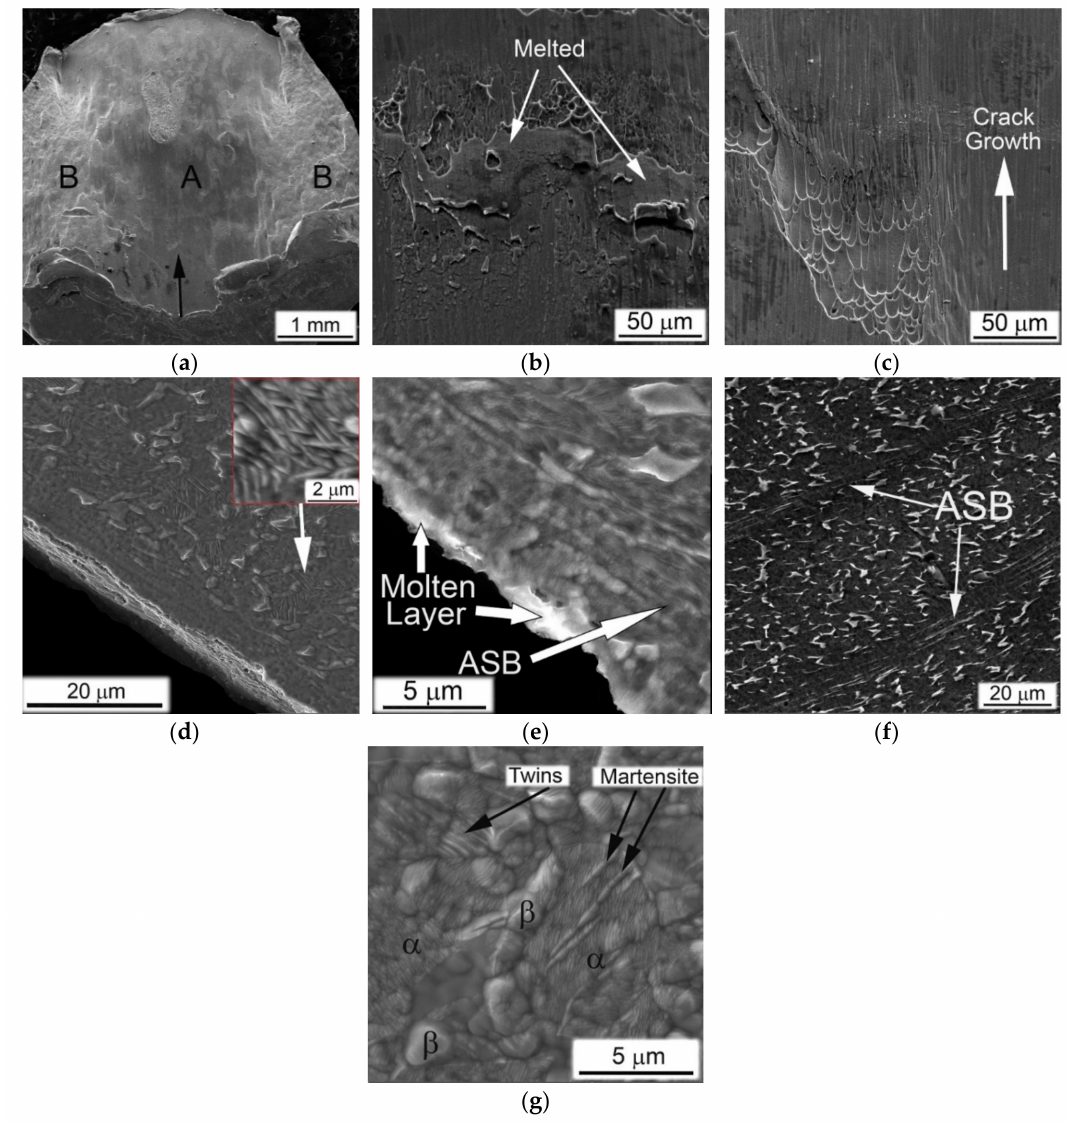
Figure 11. SEM images of the fracture surface ( a – c ), and the internal microstructure ( d – g ) of the Ti64GL specimen tested under the strain rate of 3330 s − 1 ; A—main crack spread, B—secondary cracking; ( d ) and ( e )—zone II; ( f )—zone III with secondary ASBs coming from the main crack; ( g )—zone IV. The arrow in ( a ) indicates the direction of the crack propagation from its nucleation site. SEM,